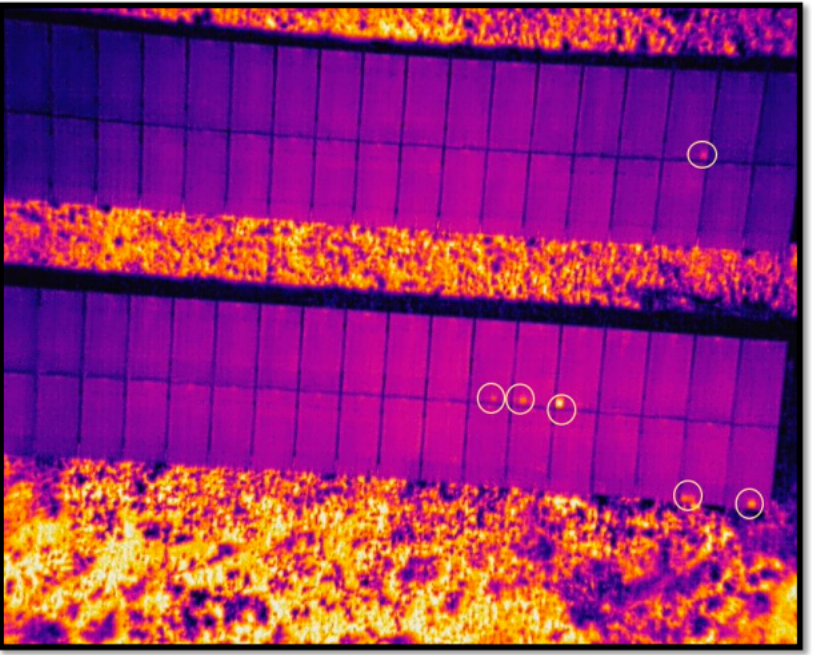
Figure 6. Thermal Image “DJI_0002_R”. An example of a visual display of the six hotspots that were detected in this photo.